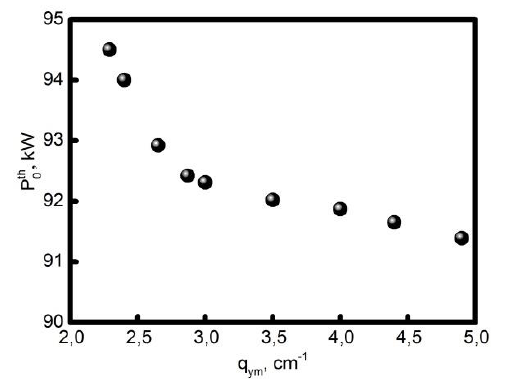
Fig. 3. Dependence of the instability threshold, which is determined numerically by solving equation (4), on the parameter q at an eigenfrequency corresponding to this ym value. The other parameters are the same as in figure 2.